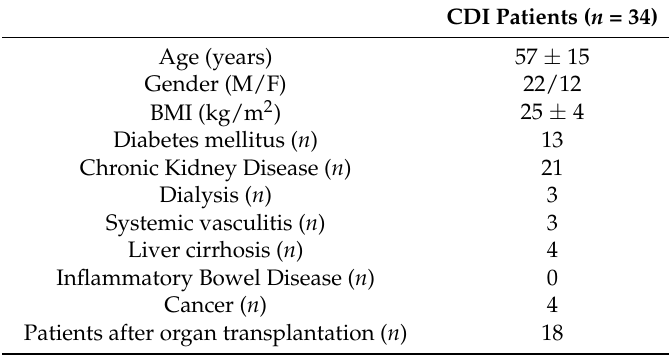
Table 1. Clinical characteristics of patients diagnosed with Clostridium difficile infections (CDI) ( n = 34).